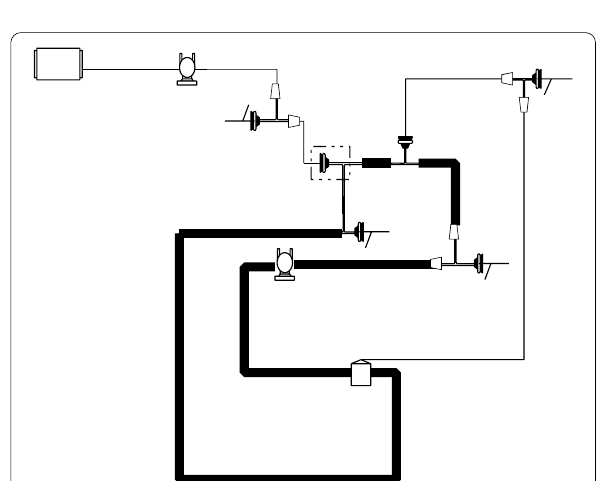
Figure 5 Diagram of the structure of the countercurrent simulation system